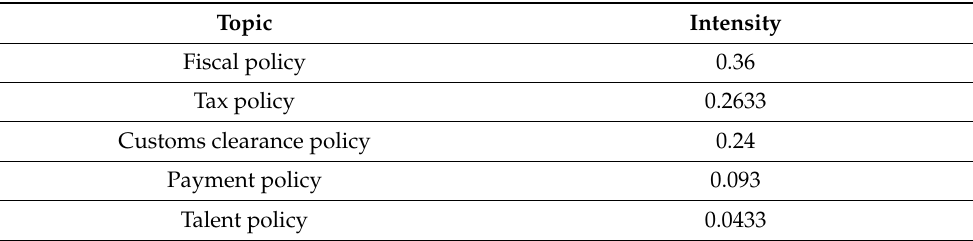
Table 3. Topic Table 3. Topic intensity.